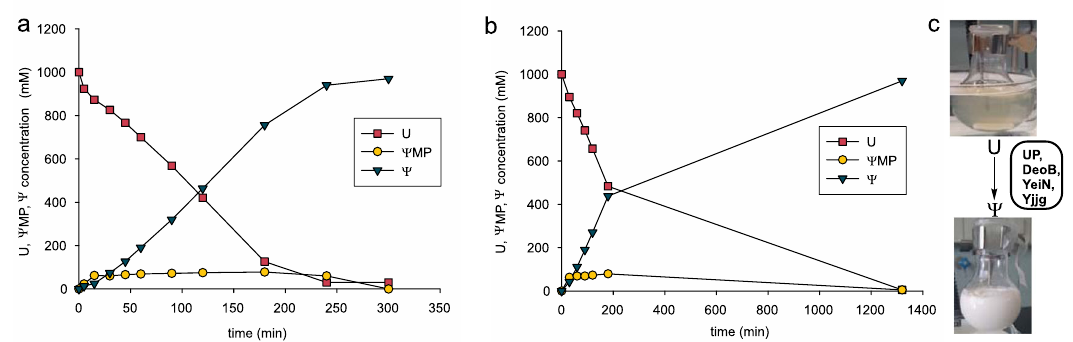
Fig. 4 | Four-enzyme cascade synthesis of Ψ . a Reaction time course of Ψ synthesis at 100 µ L (25mg) scale. Here, 0.1M potassium phosphate buffer pH 7.0, 1.0M U, 10mM MnCl 2 , 0.5mg/mL UP, 5mg/mL DeoB, 3mg/mL YeiN and 0.2mg/ mL Yjjg were incubated at 30°C ( n =1 individual experiment). b Reaction time course of Ψ synthesis at 100mL (25g) scale. Here, 0.1M potassium phosphate